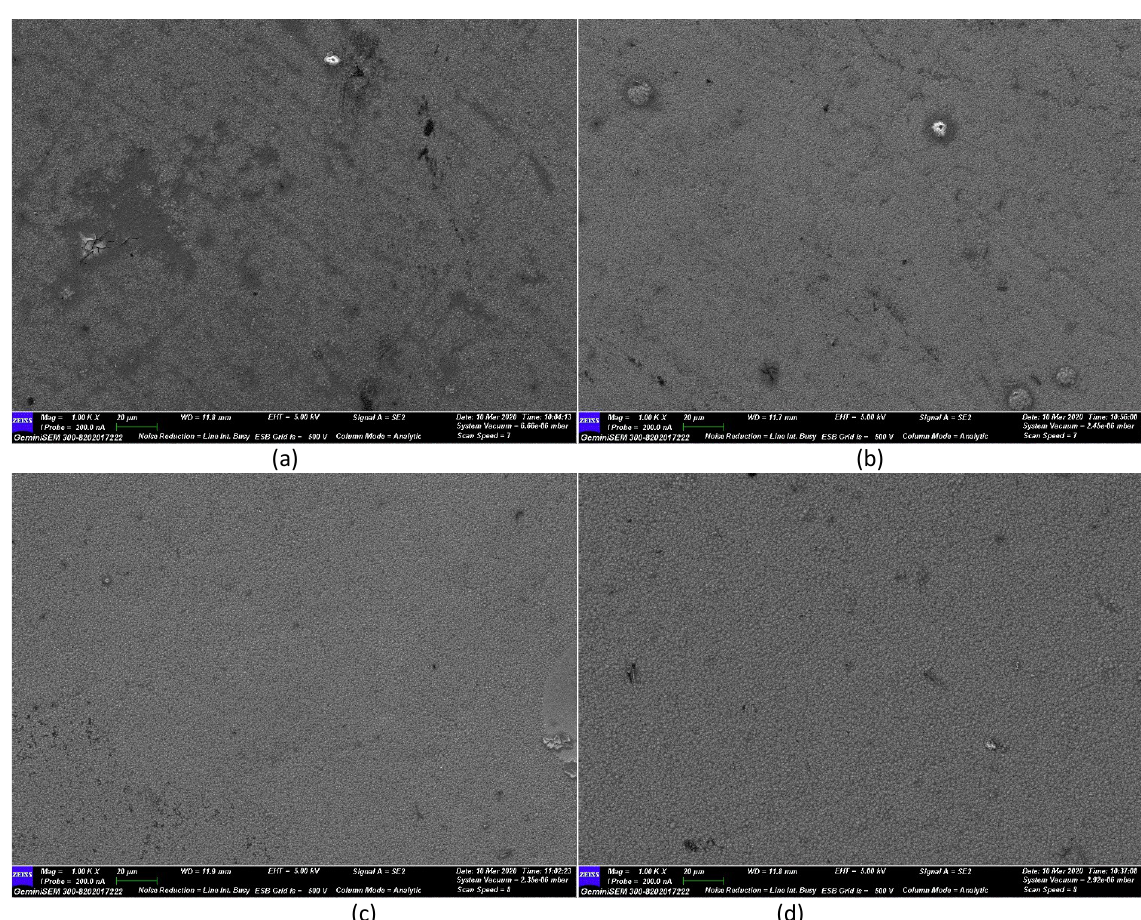
Fig.5 . Ni-Cr alloy coating microstructures for varying plating time at a constant current density of 10 A/dm 2 . a) 10 min, b) 15 min, c) 20 min and d) 25 min.